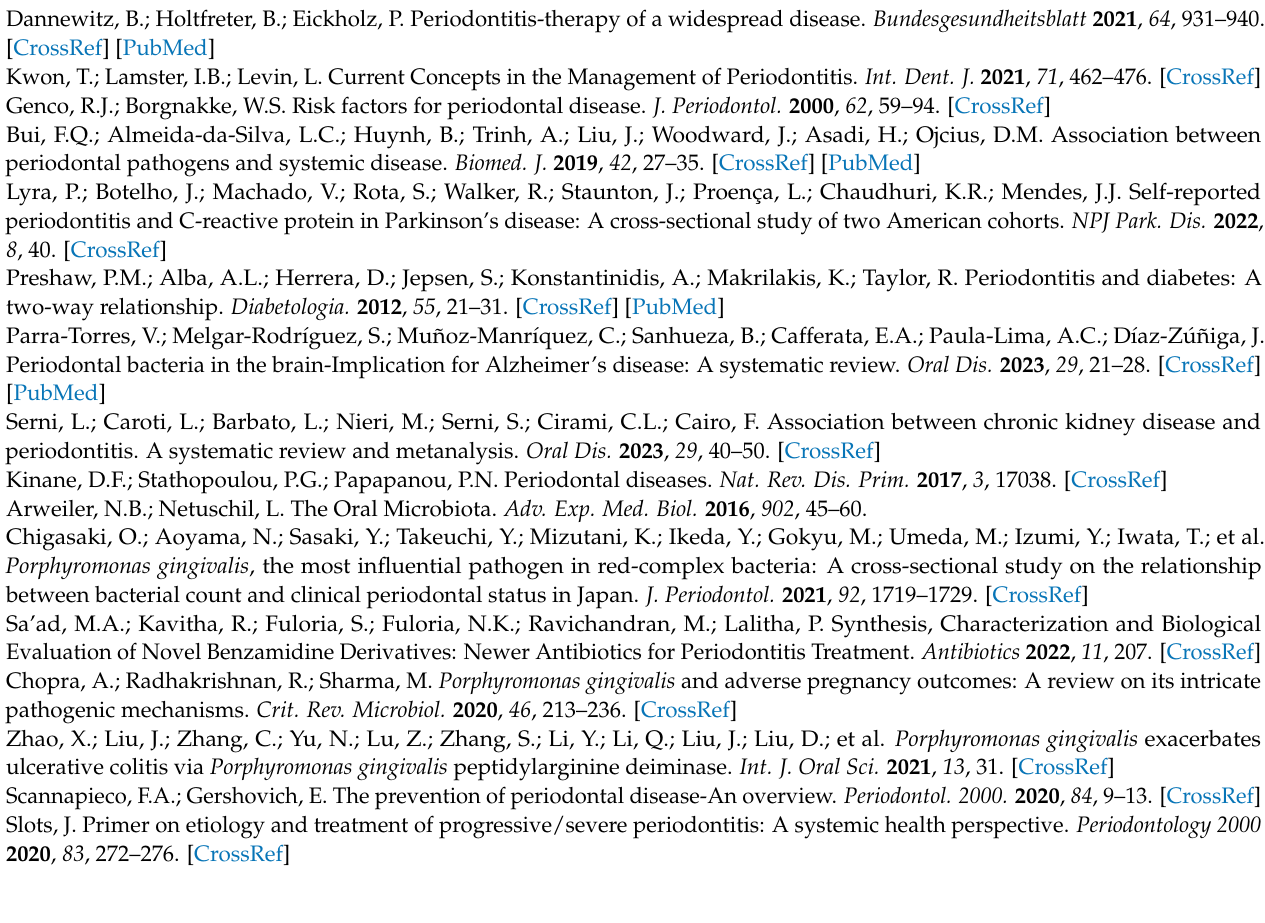
Figure S2: 1 H-NMR spectrum of compound 5a ; Figure S3: 13 C-NMR spectrum of compound 5a ; Figure S4: MASS spectrum of compound 5a ; Figure S5: FTIR spectrum of compound 6a ; Figure S6: 1 H- NMR spectrum of compound 6a ; Figure S7a: 13 C-NMR spectrum of compound 6a ; Figure S7b: 13 C- NMR spectrum of compound 6a ; Figure S7c: 13 C-NMR spectrum of compound 6a ; Figure S4: MASS spectrum of compound 6a